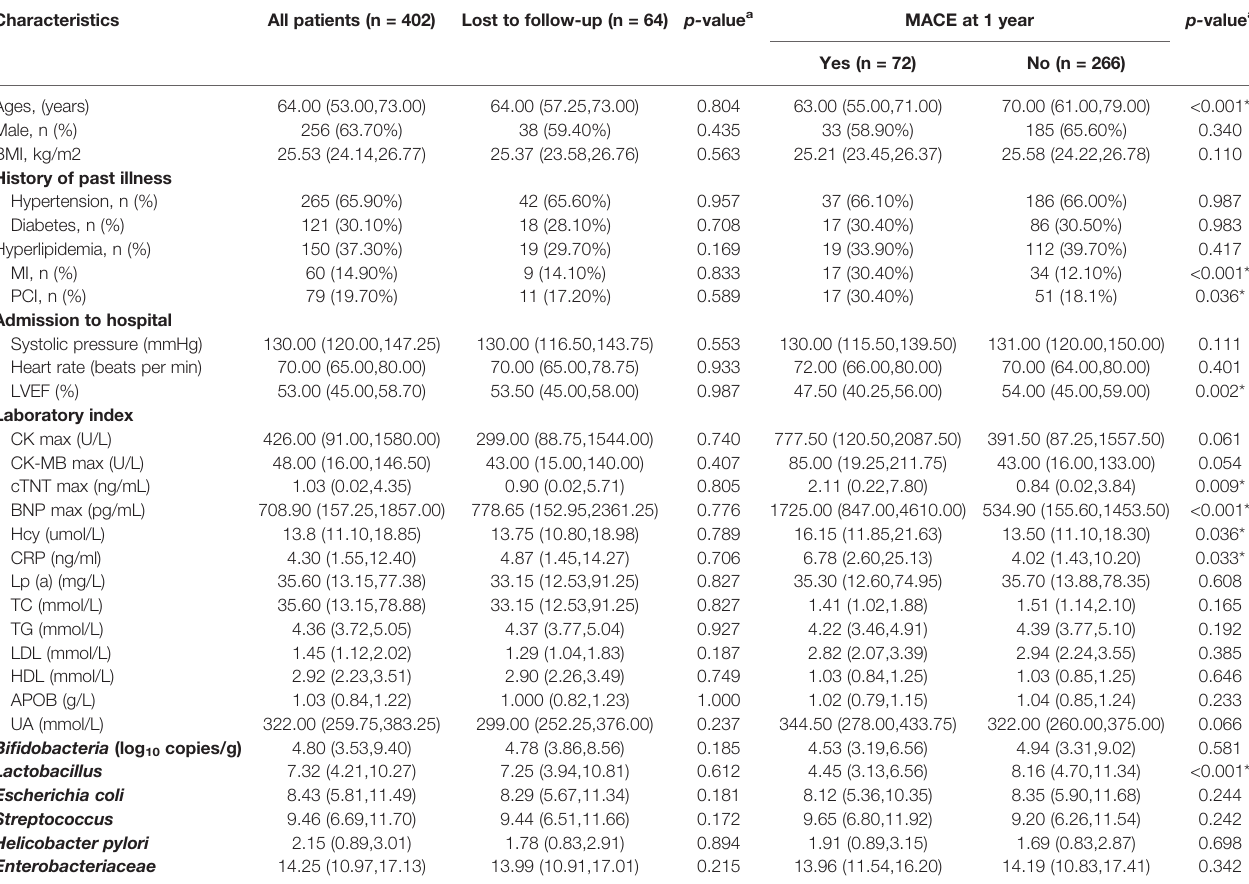
TABLE 4 | Baseline data for major adverse cardiovascular events analysis.